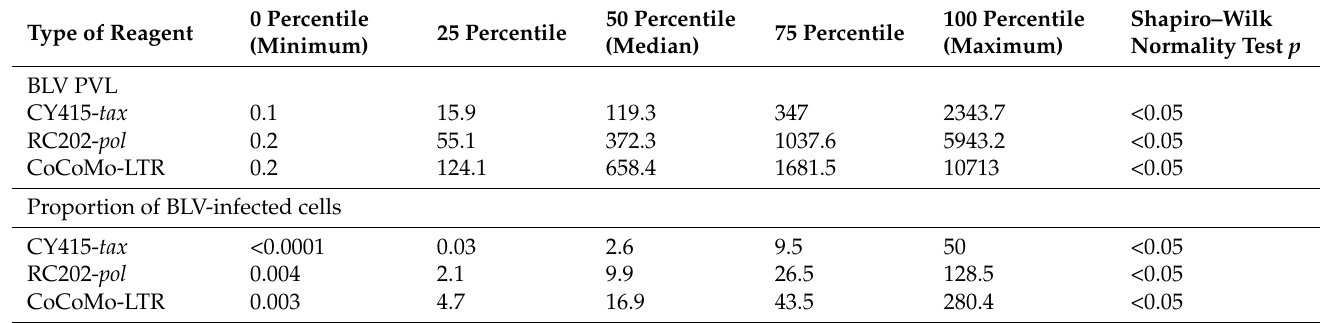
Table 1. Descriptive statistics for bovine leukemia virus (BLV) proviral load (PVL) and the proportable 312. blood samples, as determined by using three different